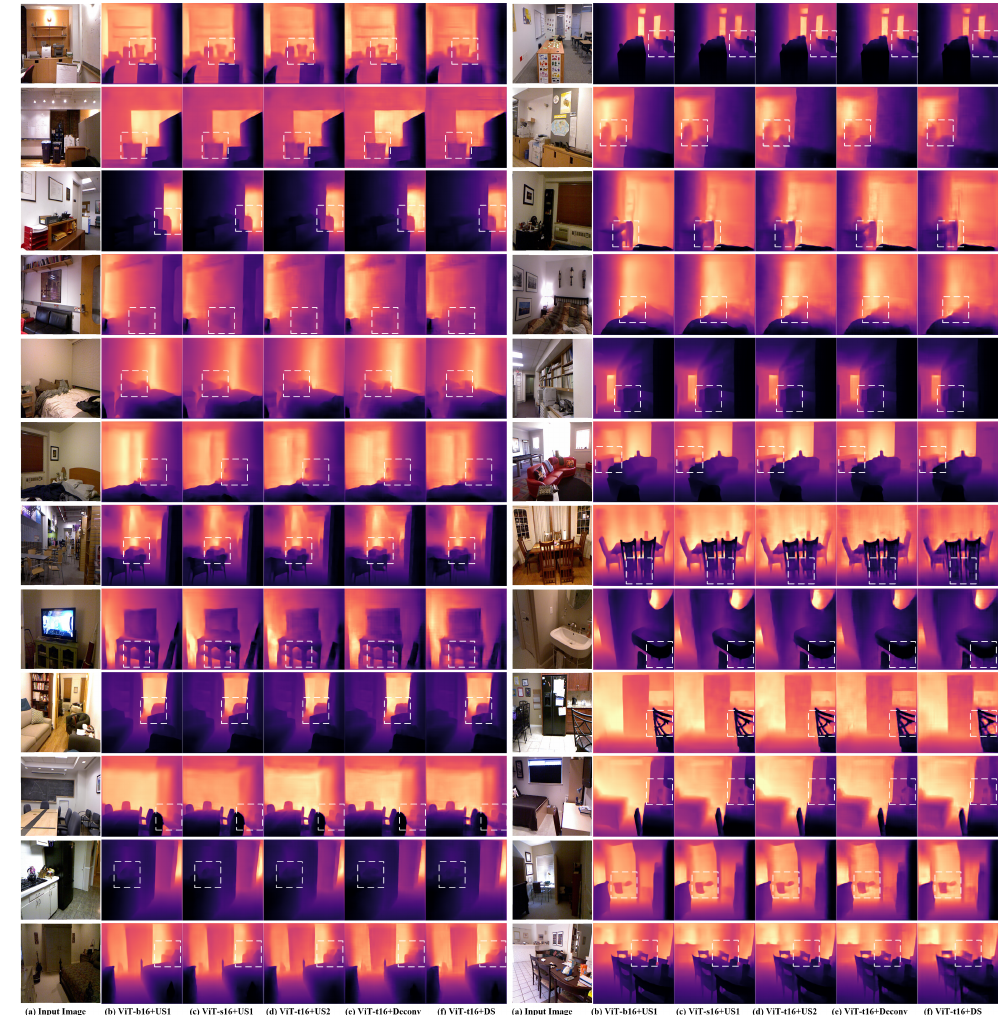
Figure 3. Sample results obtained from the proposed architectures on Cityscape validation-set: ( a ) the input image, ( b – f ) are the depth estimation results obtained from the architecture mentioned below the column, ( b ) ViT-b16 encoder and US1 decoder, ( c ) ViT-s16 encoder and US1 decoder, ( d ) ViT-t16 encoder and US2 decoder, ( e ) ViT-t16 encoder and the Deconv decoder, and ( f ) ViT-t16 encoder and (depth-to-space) DS decoder. The regions inside the dashed white boxes include slightly obvious differences between the results of the proposed architectures on the same